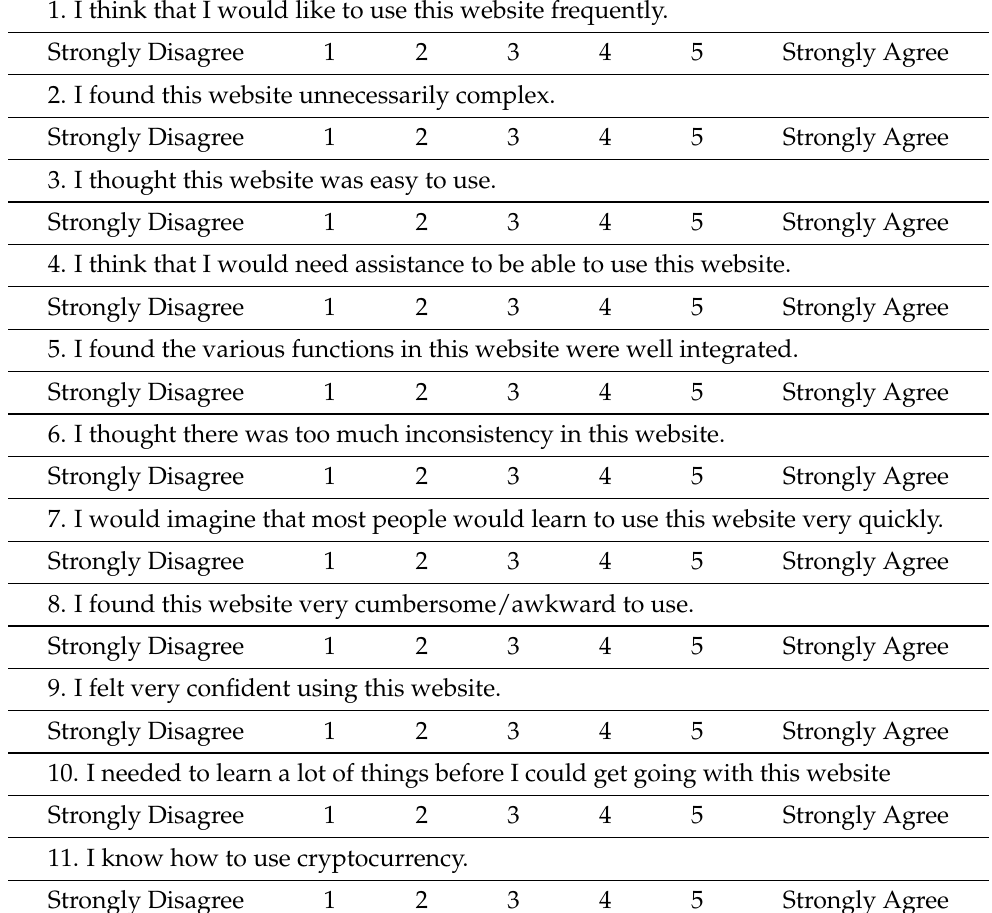
Table A2. Nebula wallet usability